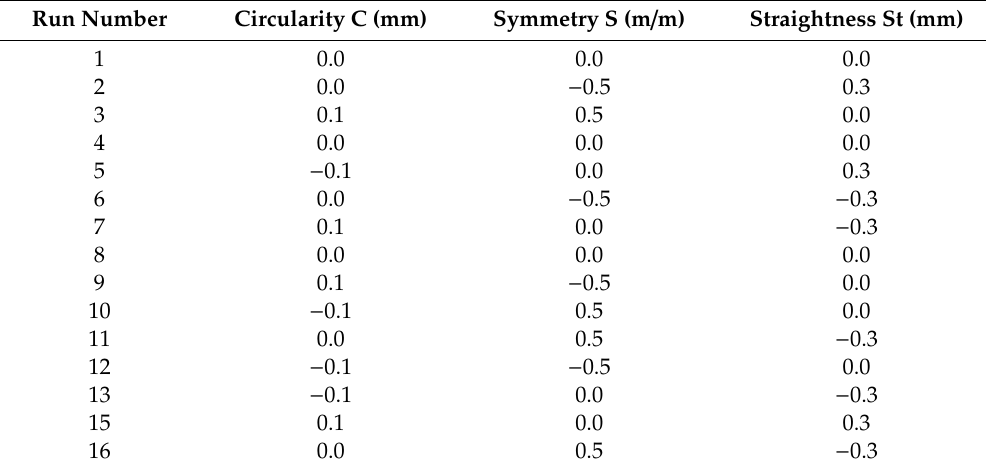
Table 5. Experimental design based in the geometric tolerance values.